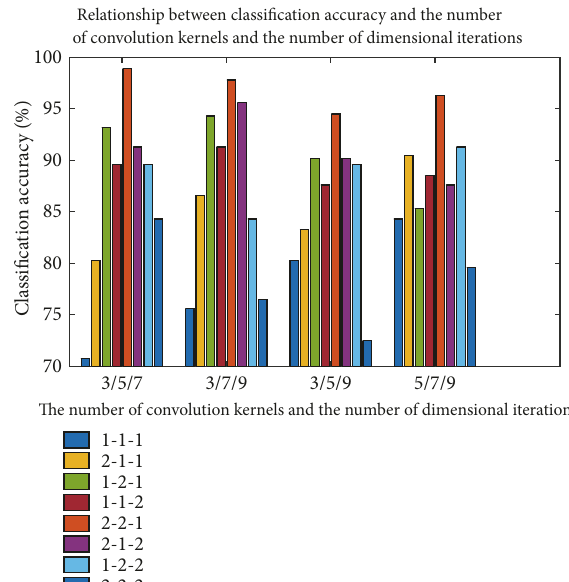
Figure 13: Relationship between classification accuracy and the number of convolution kernels and the number of dimensional